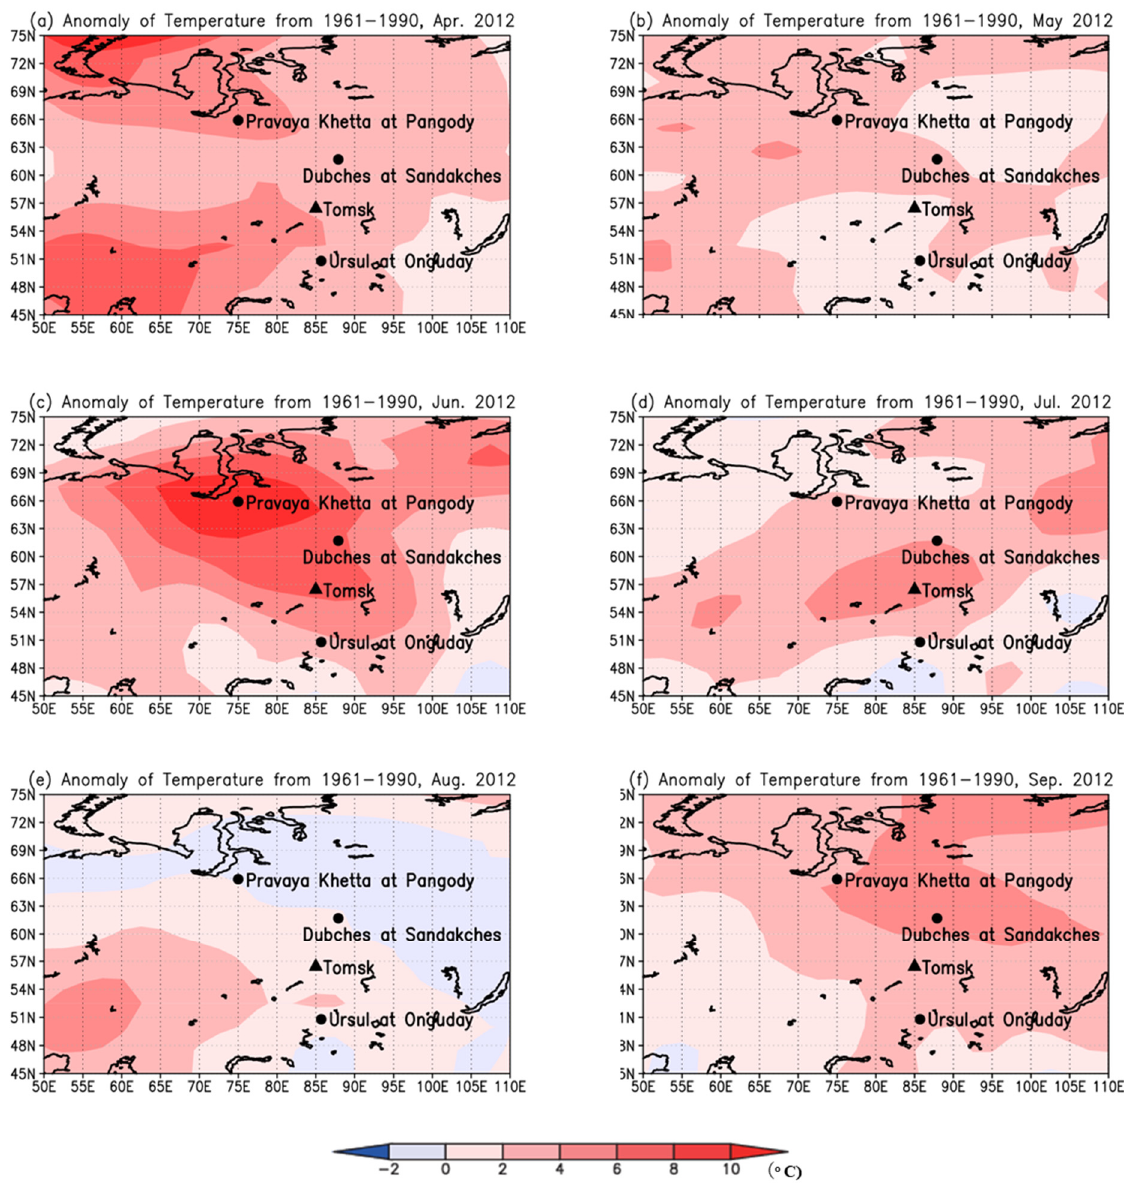
Figure 5. Same as Figure 4, but for surface air temperature. The data are derived from the NCEP/NCAR reanalysis [19]. Black circles are experimental basins, whereas black triangle represents the